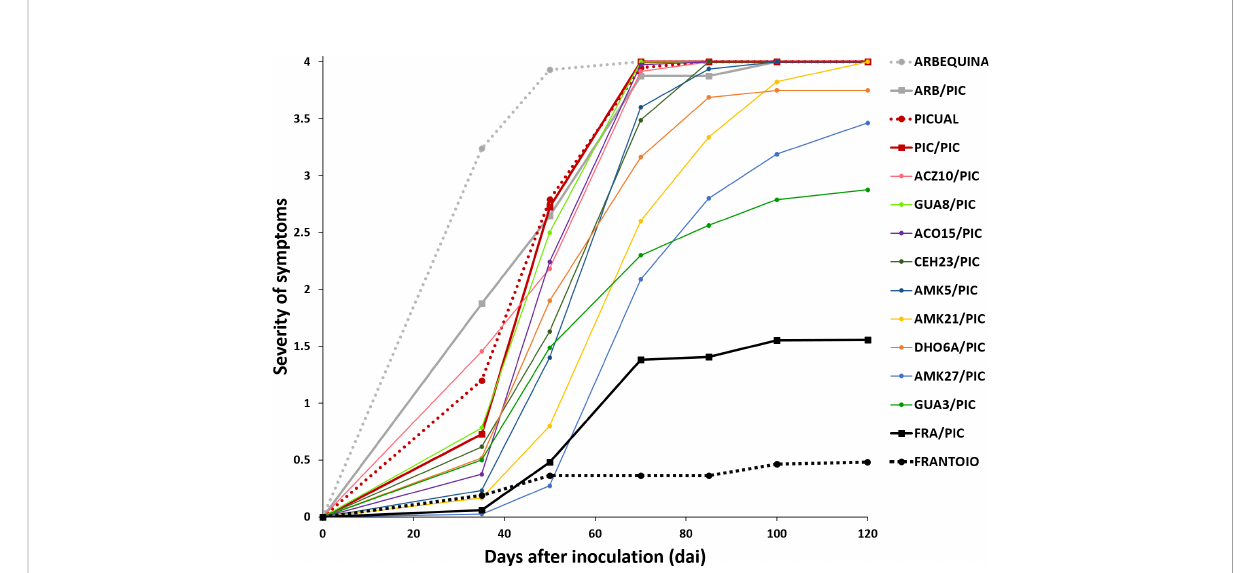
FIGURE 1 Progress of the severity of symptoms recorded in cultivar ‘ Picual ’ grafted onto wild olive rootstocks inoculated with the defoliating isolate VD117 of Verticillium dahliae . Values are the means of 24 plants. Severity of symptoms was assessed each time on a 0-4 rating scale, according to the percentage of M aximum I ntensity S ymthoms ( MIS ): apoplexy, chlorosis, leaf and shoot necrosis or defoliation: 0 = 0% MIS or no symptoms; 1 = 1-25% MIS ; 2 = 26-50% MIS ; 3 = 51-75% MIS ; 4 = 76-100% MIS or dead plants. Non-grafted ‘ Picual ’ , ‘ Arbequina ’ and ‘ Frantoio ’ reference cultivars are indicated in dashed